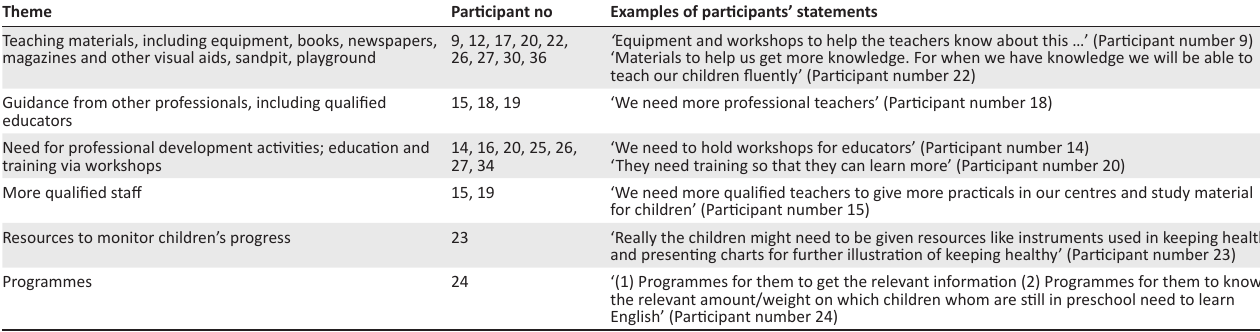
TABLE 3: Participants’ training needs: Qualitative strand ( n = 28). Theme